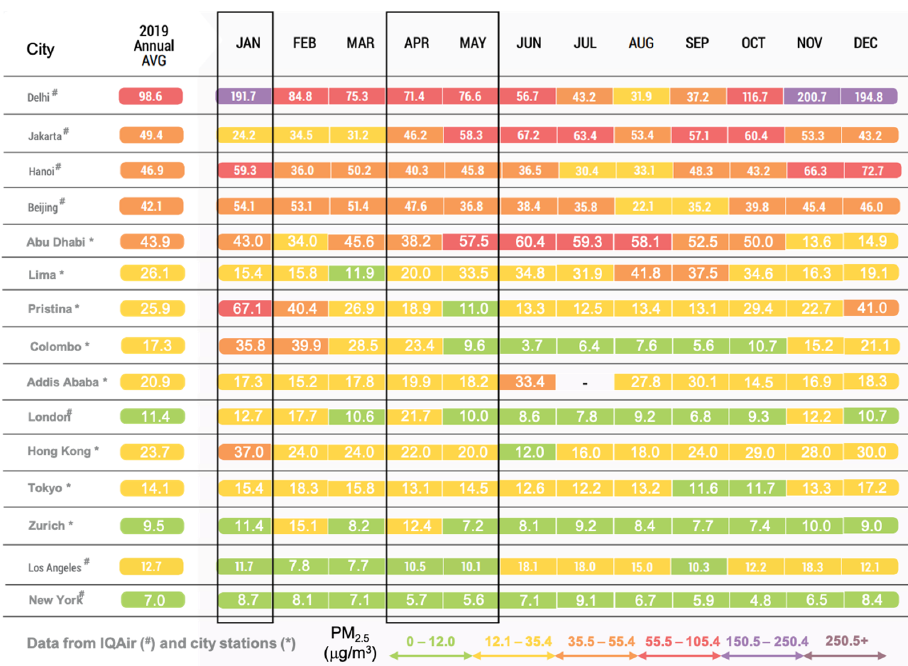
Figure 6. Summary of monthly PM 2.5 for 15 selected cities.